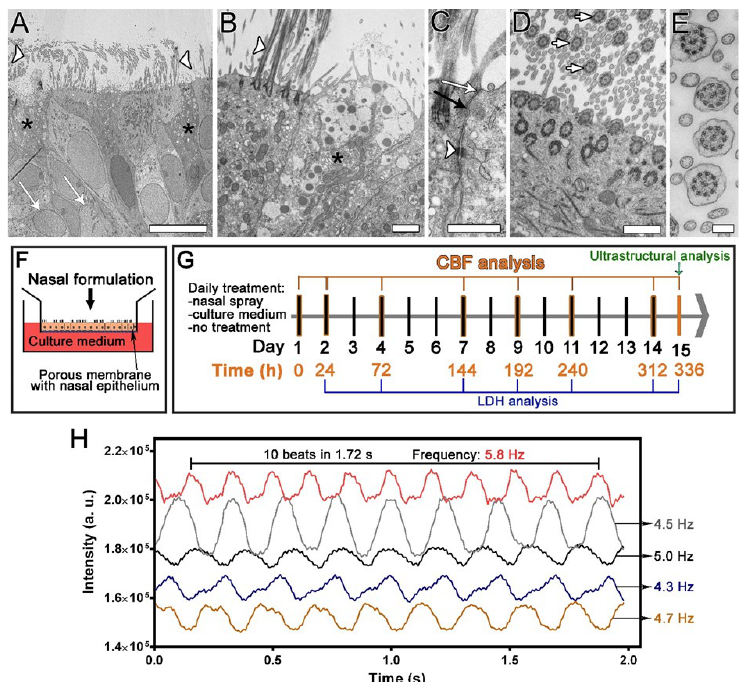
Figure 1. The design of the repeated exposure study utilising the nasal MucilAir™ in vitro models and high-speed digital phase-contrast microscopy imaging. ( A – E ) Ultrastructural properties of the nasal in vitro model. ( A – B ) A pseudostratified epithelium with ciliated cells ( A , B , white arrowheads indicate cilia), goblet cells ( A , B , black asterisks), and basal cells ( A , white arrows) is formed. ( C ) Adjacent cells are firmly connected by tight junctions (white arrow), adherent junctions (black arrow), and desmosomes (white arrowhead). ( D – E ) Characteristic axonemal structure with 9 × 2 + 2 arrangement of microtubules is viewed in cross section of the cilia (white arrows, D ; E ). Bars, 10 µm ( A ), 1 µm ( B ), 600 nm ( C , D ), 200 nm ( E ). ( F ) Nasal spray or culture medium was applied to the apical surface of the nasal in vitro models for 30 min daily and then washed off. ( G ) Cells were treated daily for 14 days, and the ciliary beat frequency (CBF) was analysed before the treatments (0 h) and at the indicated times. Ultrastructural analysis was performed at the end of the study. Lactate dehydrogenase (LDH) cytotoxicity assays were performed at the indicated times. ( H ) CBF measurements were performed by analysing the time-dependent greyscale intensity variations resulting from the repetitive cilia beating. Examples of the greyscale waveforms are shown, depicting the change in the grey intensity of the image at 5 different ROI as a function of time. The beat period was determined as the number of beats per unit time, from which the CBF was calculated (one divided by the beat period) and expressed in Hz.